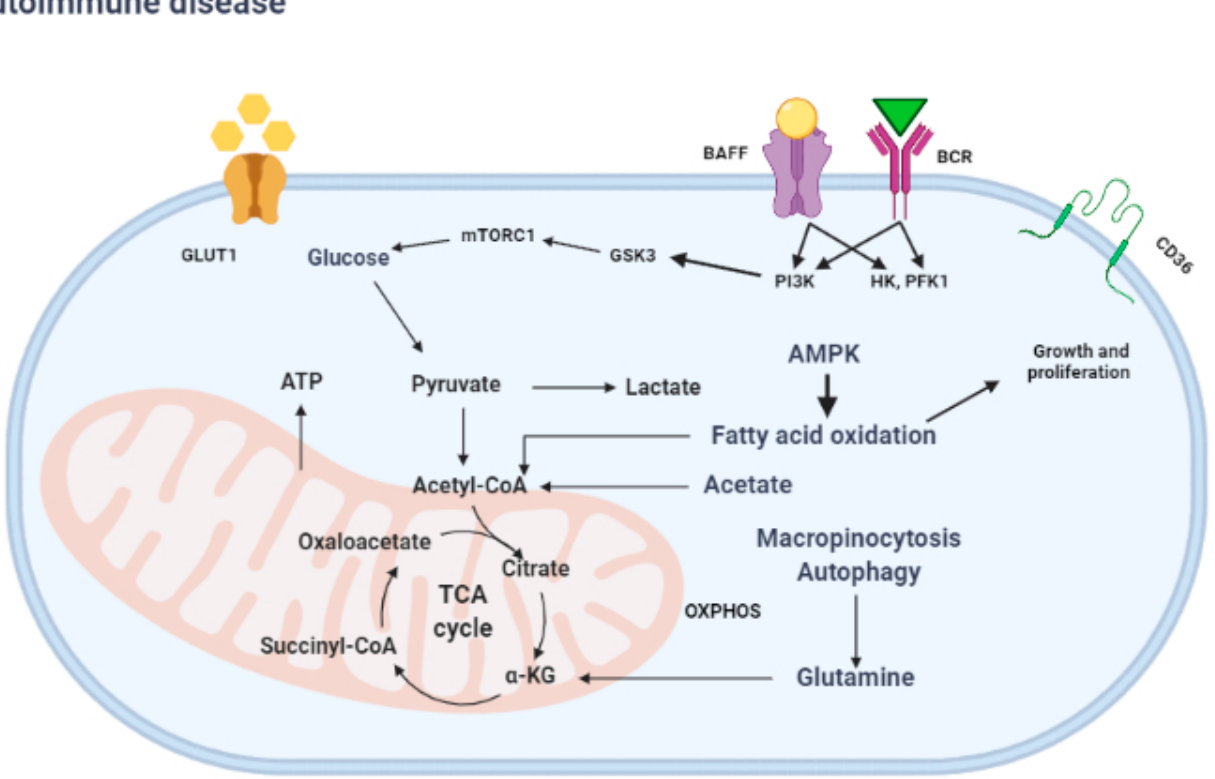
Figure 2. Autoreactive B cell’s energy metabolism: The glycolysis route, the tricarboxylic acid (TCA) cycle, and the oxidative phosphorylation (OXPHOS) system all produce ATP to fulfill cellular energy demands. Glucose, the primary energy source, enters the cell via glucose transporters (GLUT-1) and is transformed to pyruvate (PYR). PYR can take one of two paths: it can be transformed into lactate and exit the cell, or it can enter the mitochondrion and create Acetyl coenzyme A. (AcCoA). Signaling through the BCR and B-cell-activating factor (BAFF) is essential for naive B cell survival, as both of these signals activate PI3K. Importantly, the expression of other critical glucose metabolic enzymes including HK and FPK-1 (hexokinase and phosphofructokinase-1) are upregulated by BAFF signaling. Fatty acid oxidation (FAO) is also critical for the B ‐ cell growth and proliferation (Created with BioRender.com, accessed on 21 December 2021).